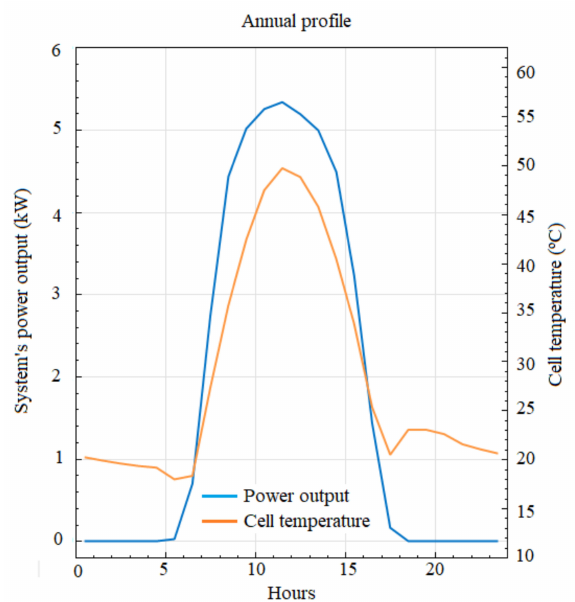
Figure 17. Relation between the cell temperature and power output (tilt angle = 23 ◦ and azimuth angle = 11 ◦